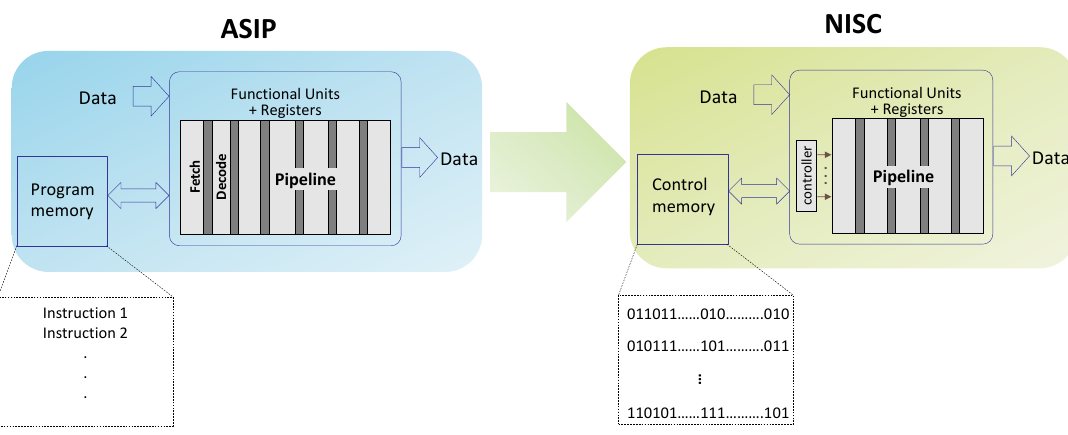
Figure 2. Transition from the application-specific instruction set processor (ASIP) to the no instruction set computer (NISC) design